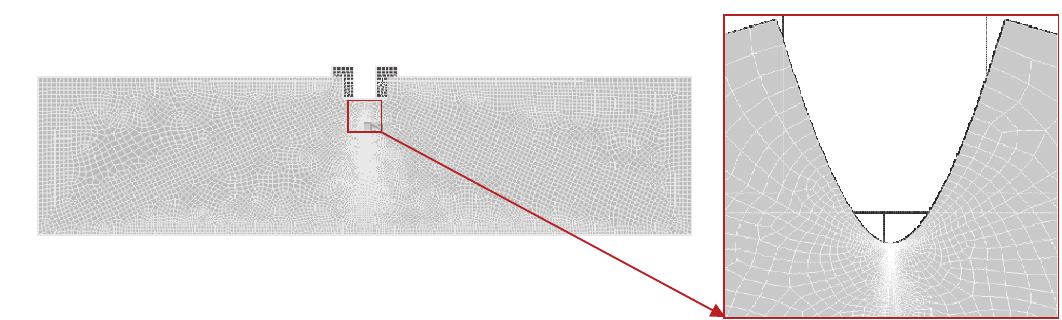
Figure 3: Example of numerical model, where boundary conditions are shown, with detail in the vicinity of the crack tip. The material input data for the concrete used in the numerical simulations were as follows: E c = 33 000 MPa and ν c = 0.2; and for the steel: E s = 210 000 MPa and ν s = 0.3. For good comparison of numerically obtain results for all cases, the load was applied as splitting force P sp = 1 000 N = 1 kN.